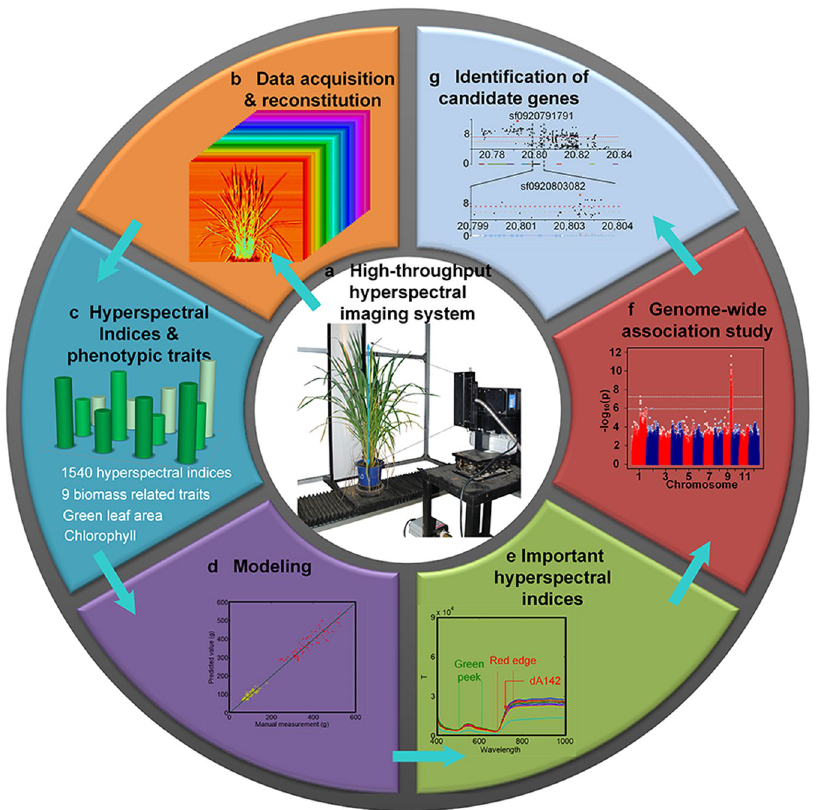
Figure 1. Combination of HHIS and GWAS. ( a ) The HHIS was designed to automatically screen the plant hyperspectral data, and the original data from the HHIS acquisition consisted of a binary data stream. ( b ) A total of 250 images were extracted from the binary data stream via data reorganization, and these images were then used to perform segmentation. ( c ) Hyperspectral indices (including total Reflectance (T), average reflectance (A), first derivative (dT, dA), second derivative (ddT, ddA), and hyperspectral characteristic index (CPT, CPA)) were extracted from the processed images. ( d ) The hyperspectral indices were used to build models of the rice phenotypic traits (including dry weight (DW), green leaf area (GLA), and chlorophyll content (Chl)). ( e ) Important hyperspectral indices can be obtained from the results of these models. ( f ) GWAS of hyperspectral indices. ( g ) Candidate gene identification based on GWAS